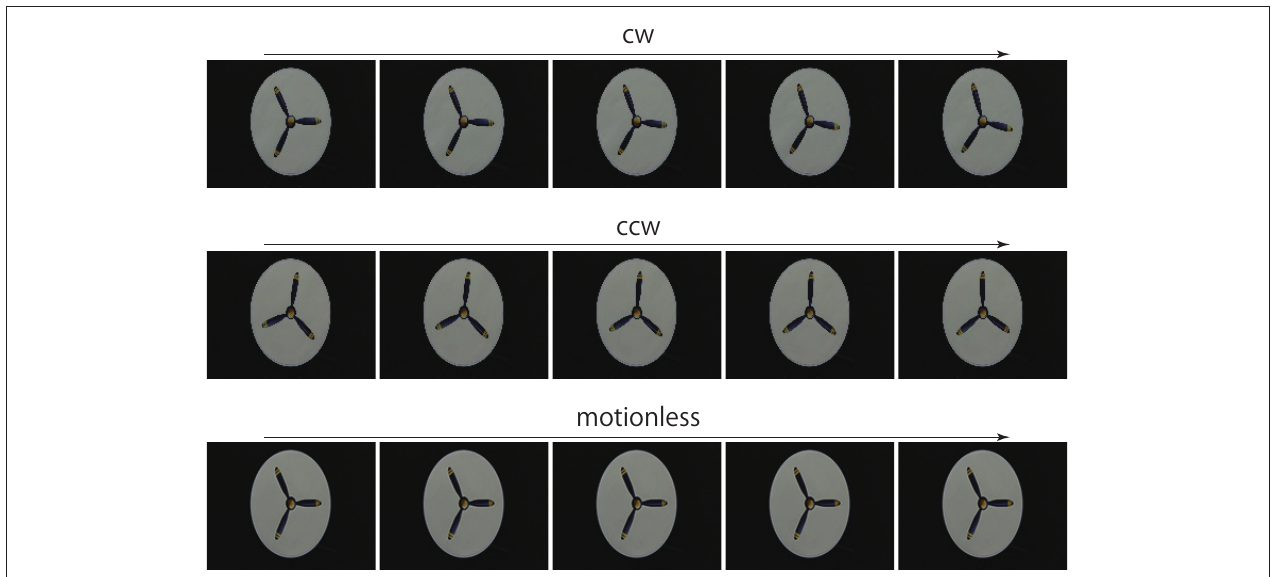
FIGURE 3 | Rotating propeller. For prediction, a series of 20 consecutive images was input to the trained networks. The first 5 consecutive images are presented here. Resolution of all figures is width 160 and height 120 pixels. The original videos are available at https://doi.org/10.6084/m9.figshare.5483680.v1.